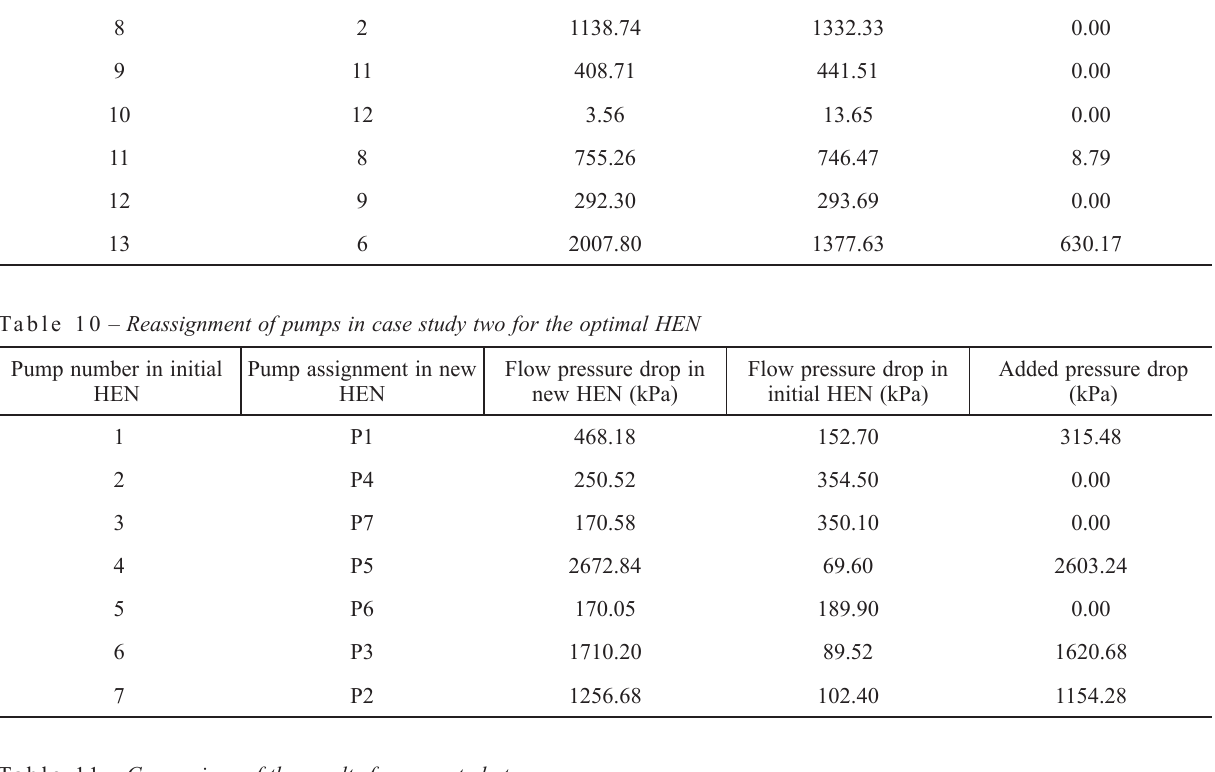
Table 11 – Comparison of the results for case study two